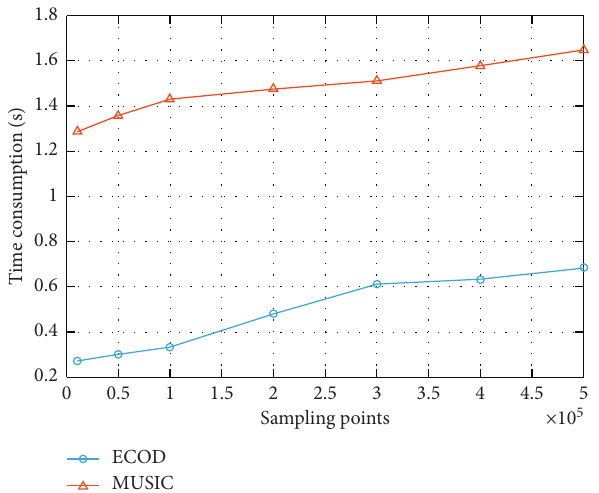
Figure 11: The time consumption comparison between the ECOD method and MUSIC method.